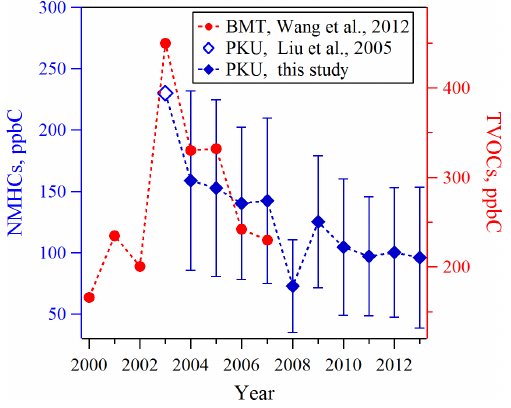
Figure 3. Temporal changes in NMHC mixing ratios (i.e., the sum of mixing ratios for 16 measured C2–C8 hydrocarbons) measured at the PKU site (blue diamonds) during August from 2003 to 2012 and summertime levels of TVOCs (i.e., the sum of 55 measured C4–C10 hydrocarbons and halocarbons) measured at the Beijing Meteorological Tower (BMT) site (red dots) reported by Wang et al. (2012) from 2000 to 2007. The error bars correspond to standard deviations of NMHC levels for each year.